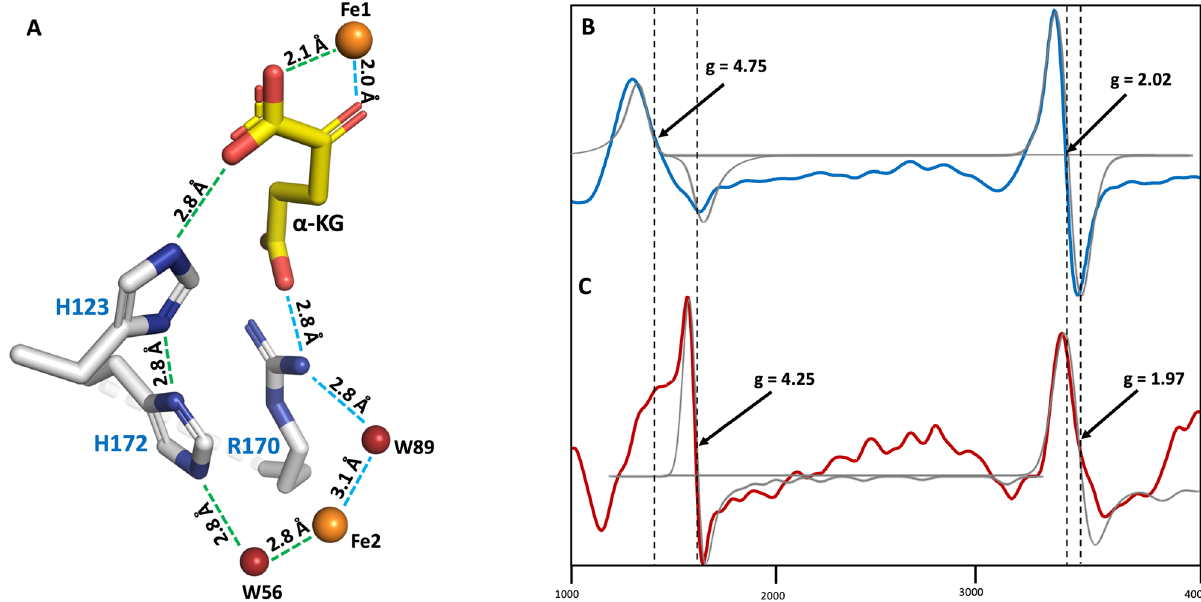
Fig. 5 Schematic representation of the CT Path in Cpz10 and EPR spectra. A The hidden CT conduit is schematically presented, where CT routes are proposed from Fe2 en route pass points of Wt89, His172, His123, and α KG to Fe1 or alternatively through Arg170, α KG to Fe1. B EPR spectrum (black line) for an enzymatic reaction of Cpz10 in a 50 mM potassium phosphate buffer solution at pH 7.5 containing 0.2 mM α KG and 0.2 mM ascorbic acid under an aerobic condition; simulated EPR spectrum (blue line). C EPR spectrum (black line) for an enzymatic reaction of Cpz10 in a 50 mM potassium phosphate buffer solution containing 0.2 mM α KG, 0.2 mM ascorbic acid, and 0.2 mM methionine at pH 7.5 under an aerobic condition; simulated EPR spectrum (red line).